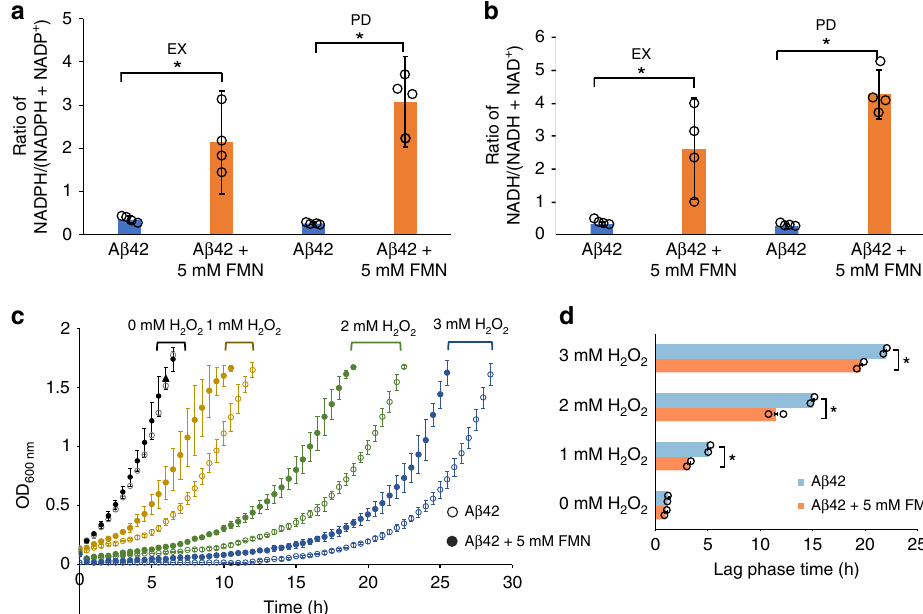
Fig. 5 FMN supplementation increases cellular tolerance to oxidative stress in A β 42 strain. a Ratio of NADPH/(NADPH + NADP + ) in the A β 42 strain without or with FMN supplementation during EX and PD growth phases respectively ( n = 4 ± SD; * P < 0.01). b Ratio of NADH/(NADH + NAD + ) in the A β 42 strain without or with FMN supplementation during EX and PD growth phases ( n = 4 ± SD; * P < 0.01). c , d A β 42 cells display an increased H 2 O 2 tolerance when supplemented with FMN. A β 42 cells without or with FMN supplement were grown to mid exponential phase (OD ≈ 0.5 – 0.6) and treated with different concentrations of H 2 O 2 . Cell growth was monitored using a microplate reader ( c ) with lag phase time analyzed using the R package growthrates ( d ). The lag phase indicates the time from H 2 O 2 treatment until maximum growth rate, determined by the exponential growth phase. Results shown are average values ± SD of biological duplicates. The asterisk (*) indicates signi fi cant difference ( p < 0.05). Source data are provided as a Source Data fi